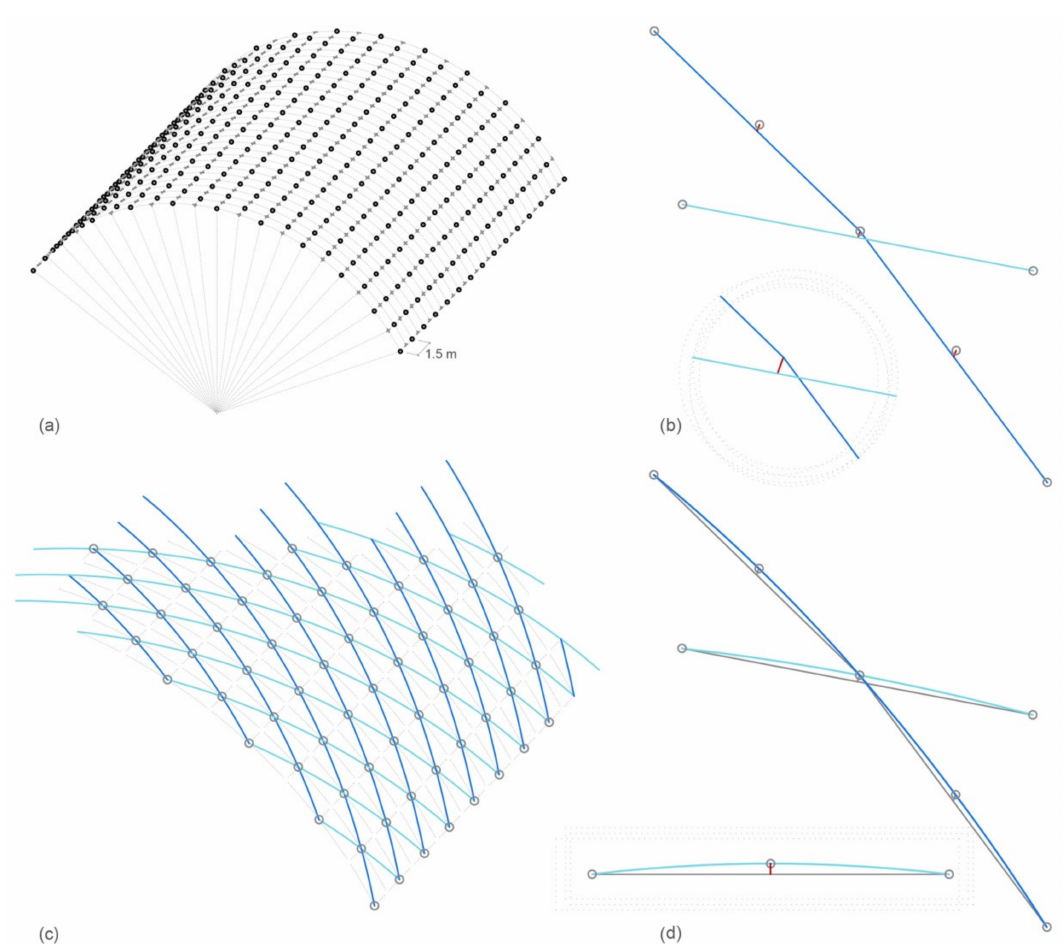
Figure 7. The process of division of cylinder surface to equal parts: ( a ) axonometric view of the lamellae vault with nodes of the lamellae spaced 1.5 m apart, ( b ) detail of each lamellae span and the connections at the nodes, ( c ) segment of a lamellae vault with all arched axes of the lamellae intersecting in the node and ( d ) detail of the arched lamellae defined by the span and rise lines. The arched axis of the lamellae was designed using the two lines, which defined the plane for each lamella in the structure. The ends of the line connecting the nodes and the top of the line presenting the connection define the arch span and rise (Figure 7d). The